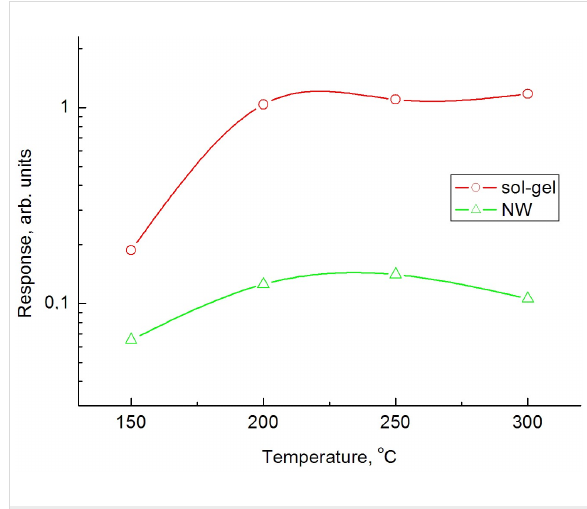
terial. The same effect is observed for the tin dioxide nano- wires prepared by the dry gas-transport